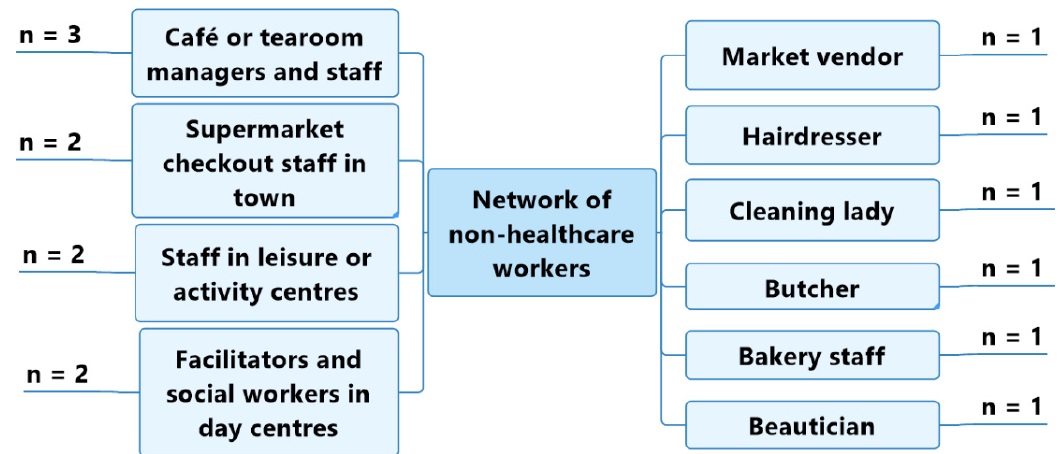
Figure 4. Non-healthcare workers regularly encountered by participants with a probable or diagnosed slight cognitive impairment or mild-to-moderate dementia.